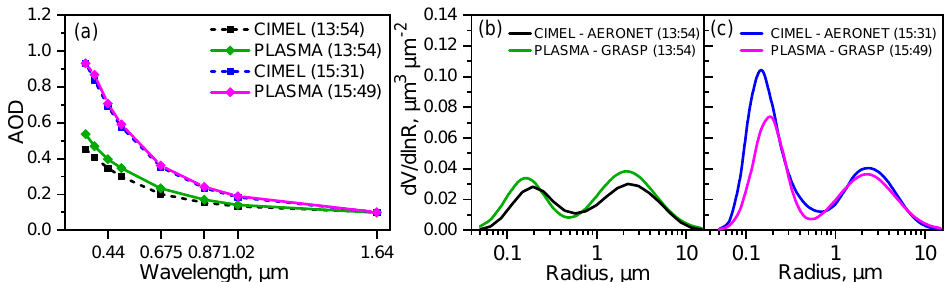
Figure 7. (a) Spectral AOD from PLASMA sun photometer measurements at Dunkerque, on 26 August 2016, 13:54UTC (green solid line) and Lille, 15:49UTC (magenta solid line). The closest spectral AOD from Dunkerque and Lille AERONET sites are represented with dashed lines. The corresponding total column aerosol volume size distribution retrieved by GRASP-AOD inversions for (b) Dunkerque and (c) Lille sites. The size distributions from the closest AERONET standard inversion for Dunkerque (13:54) and Lille (15:31) are also represented as reference.